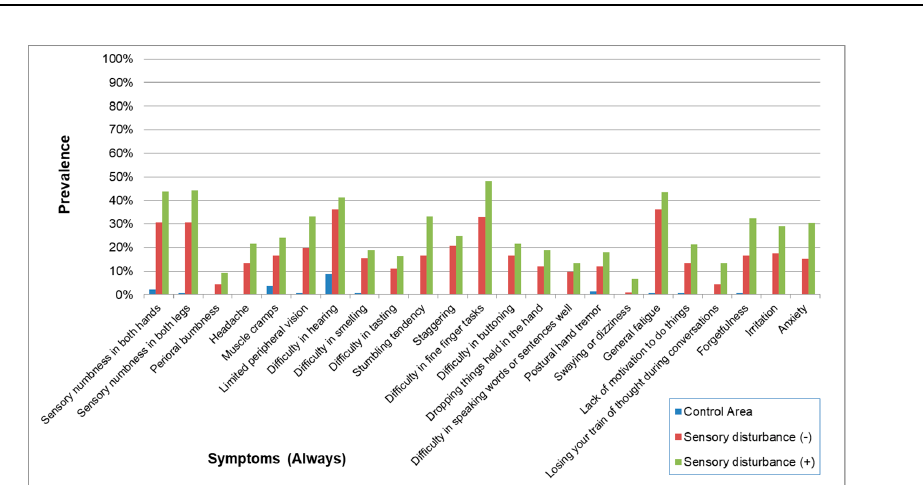
Figure 15. Prevalence of symptoms (Always) in subjects with and without sensory disturbance. The prevalence of symptoms was a little lower in subjects without sensory disturbance than in subjects with sensory disturbance but was apparently higher than the Control Area. The prevalence patterns were similar in exposed subjects with and without sensory disturbance.